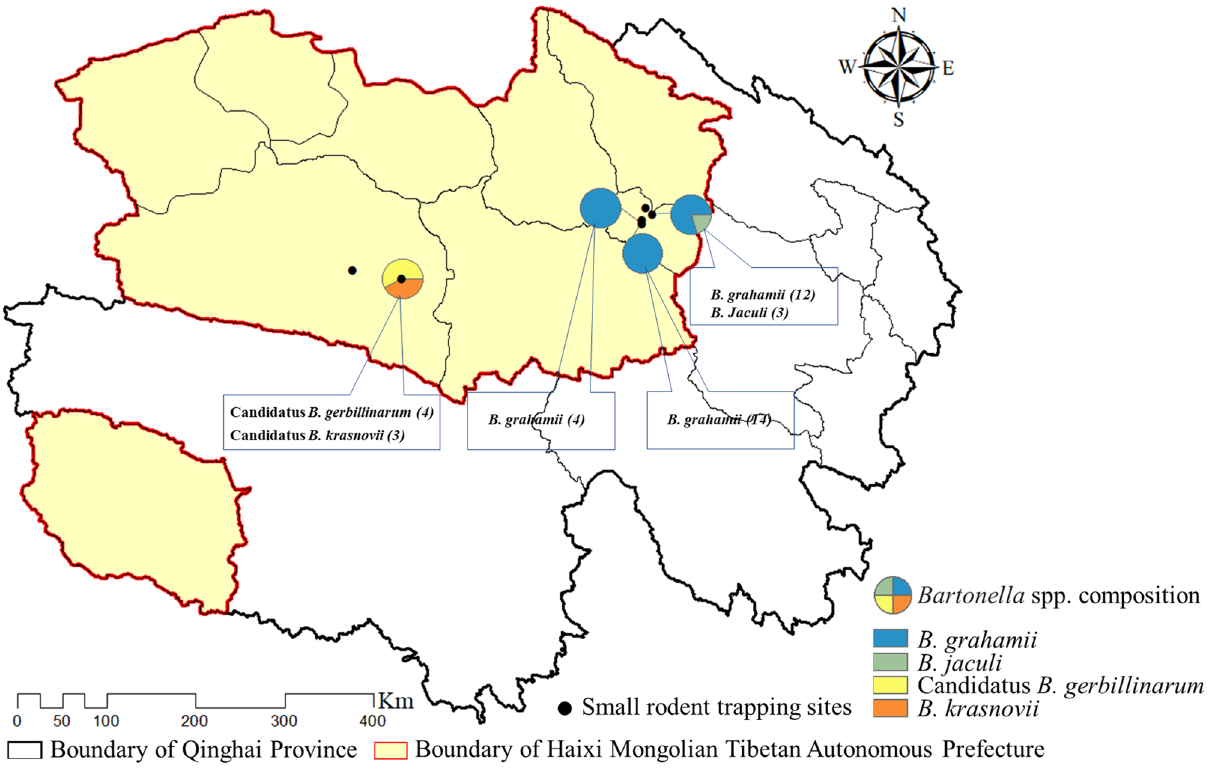
Figure 3. Bartonella species composition in different sampling sites in two counties of Haixi Prefecture, China.